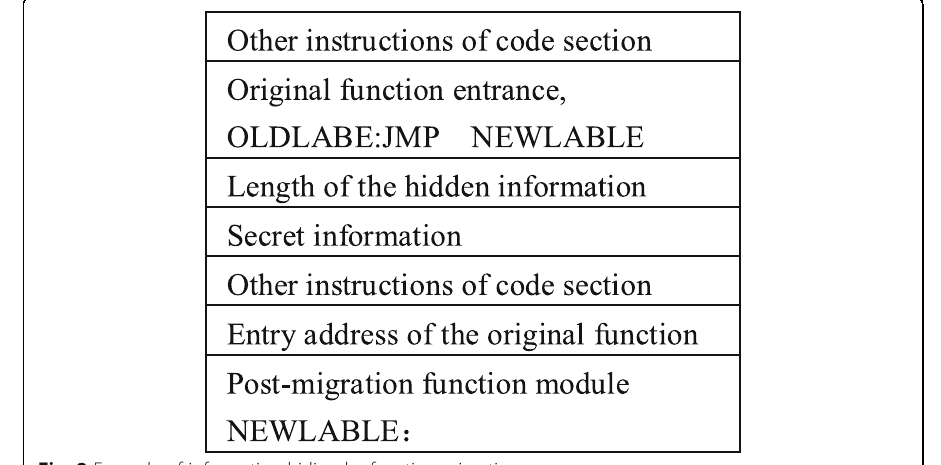
Fig. 2 Example of information hiding by function